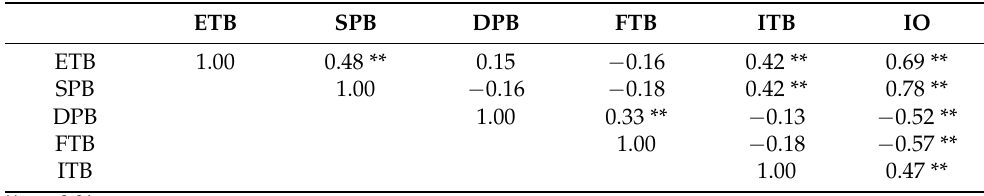
Table 8. Intercorrelations among OCDQ-RS